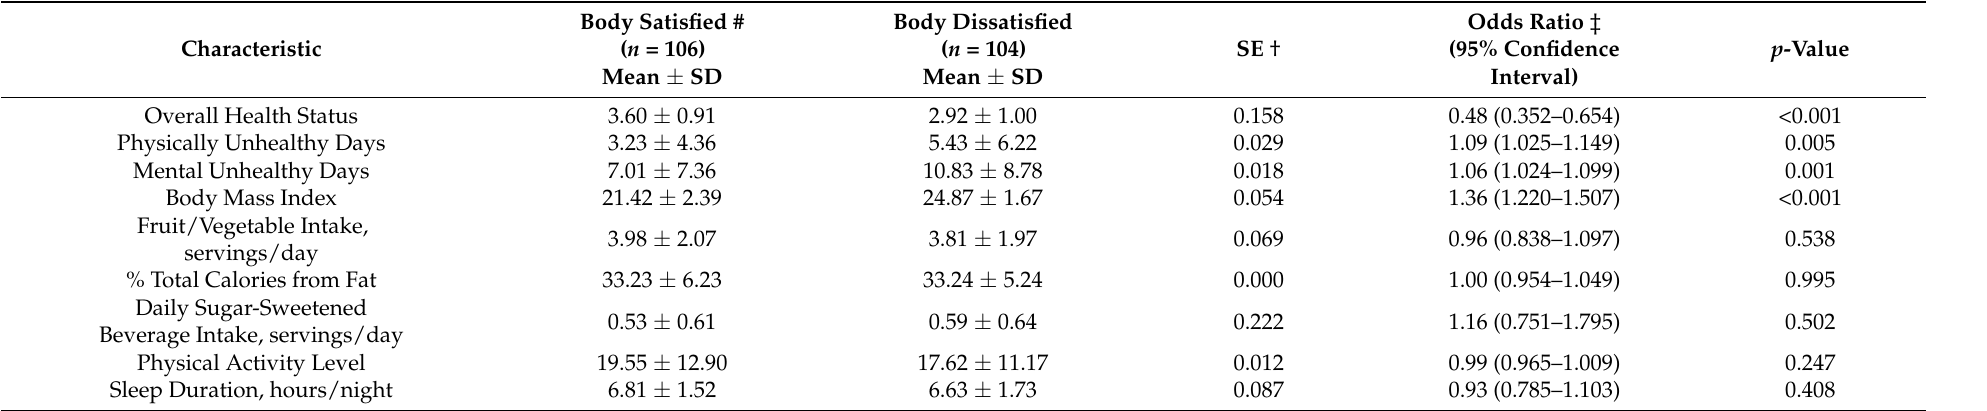
Table 3. Binary Logistic Regression Analyses Examining Associations of Health Status and Weight-Related Behaviors with Body Dissatisfaction of Young Adult Women College Students (N =